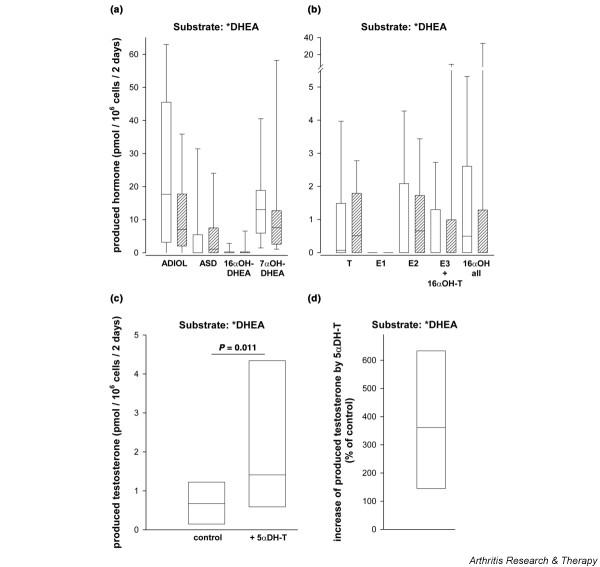
Conversion of DHEA into downstream steroid hormones in mixed synovial cells. (a,b) Spontaneous conversion of radiolabeled DHEA into downstream metabolites in OA (open bars, n = 24) and RA patients (hatched bars, n = 23). The E3 and 16αOH-testosterone produced are shown together in one bar because only one spot was detected for both steroids using TLC. The bar '16αOH all' reflects the sum of all 16α-hydroxylated products. (c,d) Conversion of radiolabeled DHEA into testosterone under the influence of 5α-dihydrotestosterone as investigated in three OA and one RA patient. All panels: values are given as pmol/106 cells/48 hr as box blots with the 5th, 25th, 50th (median), 75th, and 95th percentile when applicable. * Denotes radiolabeled substrate. OA, osteoarthritis; RA, rheumatoid arthritis. Other abbreviations are as given in the legend to Fig. 1.